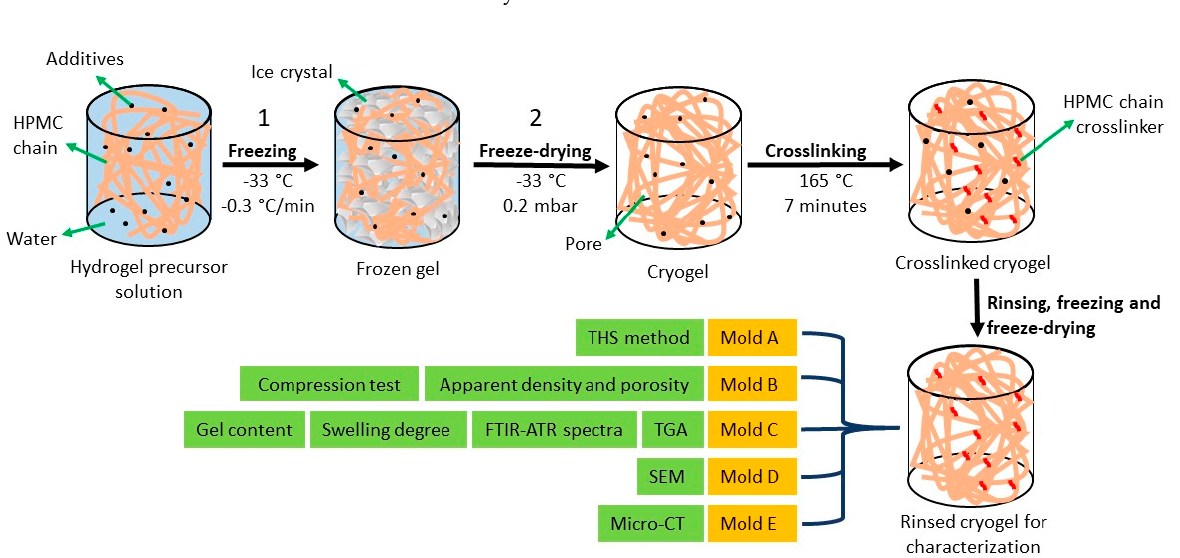
FTIR-ATR spectra. Figure S2: Histogram of average pore size. Figure S3: Δ T vs. ln t. Figure S4: TG/DTG curves. Figure S5: TG curves. Figure S6: Water sorption and swelling degree experiments. Figure S7: Determination of viscometric average molar mass of HPMC. Figure S8: Surface tension vs. logarithm of the concentration (mM) of (a) AOT and (b) Kolliphor ® EL. Figure S9: (a) Styrofoam boxes arranged for the precursor gels freezing; (b) top-view representation of boxes (gray) with the distances in millimeters among the molds (symmetrically positioned in the center) and boxes as well as their wall thickness and size. (c) The temperature of points A (hydrogel sample in mold A), B, C, and D (outer surface of each box) was measured using thermistors as a function of time. Figure S10: Storage (G ′ ) and loss (G ″ ) moduli obtained by DSST tests for the hydrogels. Figure S11: Curves obtained by the SAOS tests performed at 25.0 ± 0.5 °C.